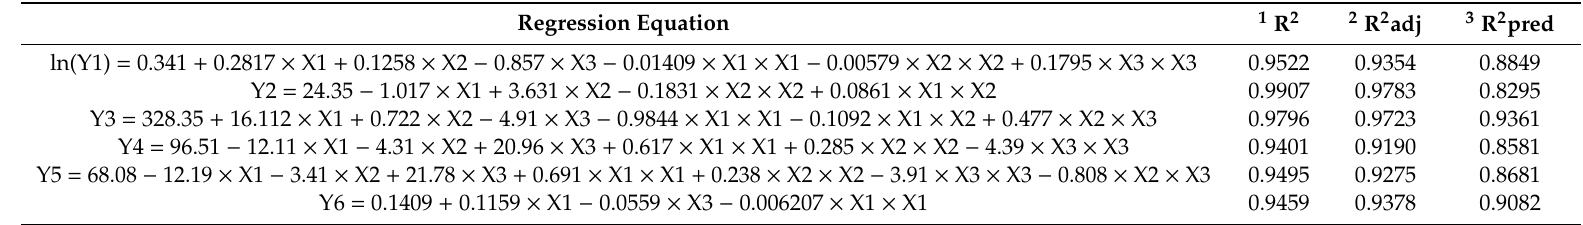
Table 3. Regression equation and determination coe ffi cients for response surface regression of the sun protection factor (Y1), antioxidant activity (Y2), critical wavelength (Y3), UVA transmittance (Y4), UVB transmittance (Y5), and UVA / UVB ratio (Y6) as functions of the concentration of sunscreen filters (X1), concentration of extract (X2), and time of irradiation (X3). Regression Equation 1 R